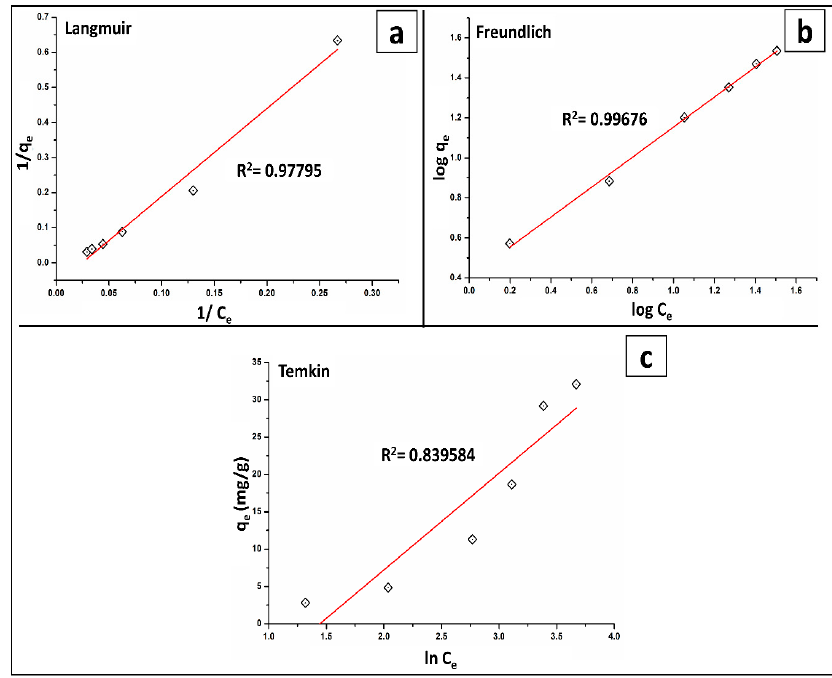
Figure 7. Adsorption isotherm models of ( a ) Langmuir, ( b ) Freundlich, and ( c ) Temkin of As(V) by the BT-An@Zetag composite. the BT-An@Zetag Table 3. Thermodynamic parameters of the adsorption process based on the Van’t Hoff plot. Parameter